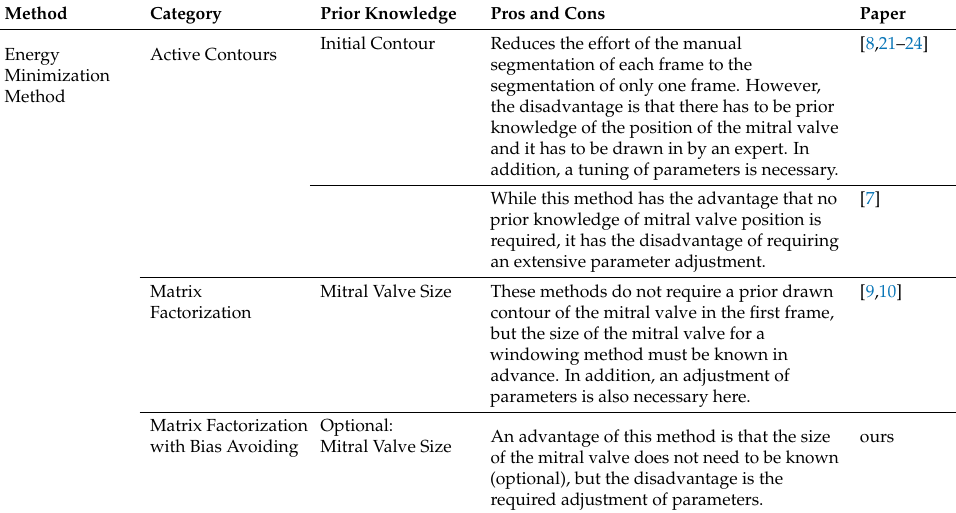
Table 1. Summary of mitral valve segmentation methods for echocardiographic